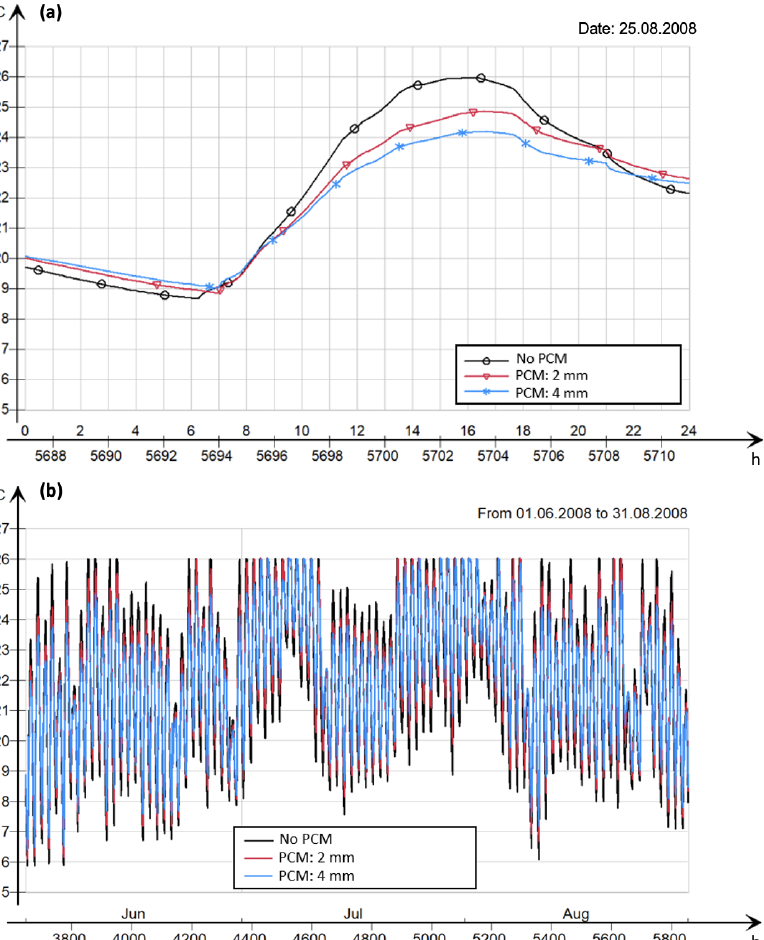
Figure 7. Indoor operative temperature of a representative cubicle. Case: Hybrid NV, 3 ACH.